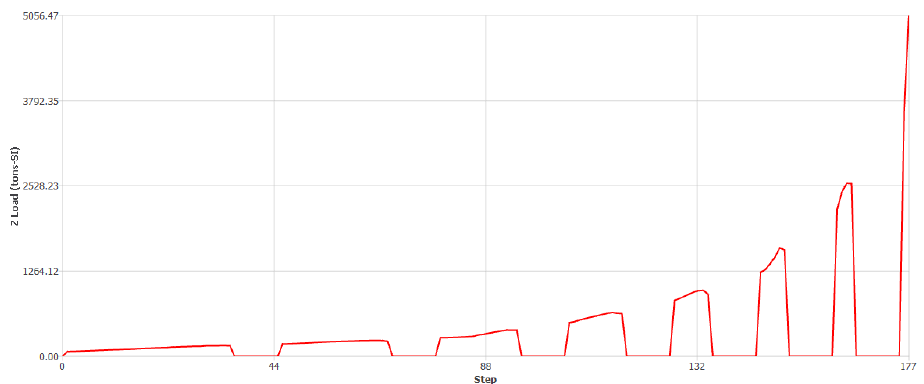
Figure 18. Plotted Load vs. Step for near-net pinion shaft with teeth formation incorporated.